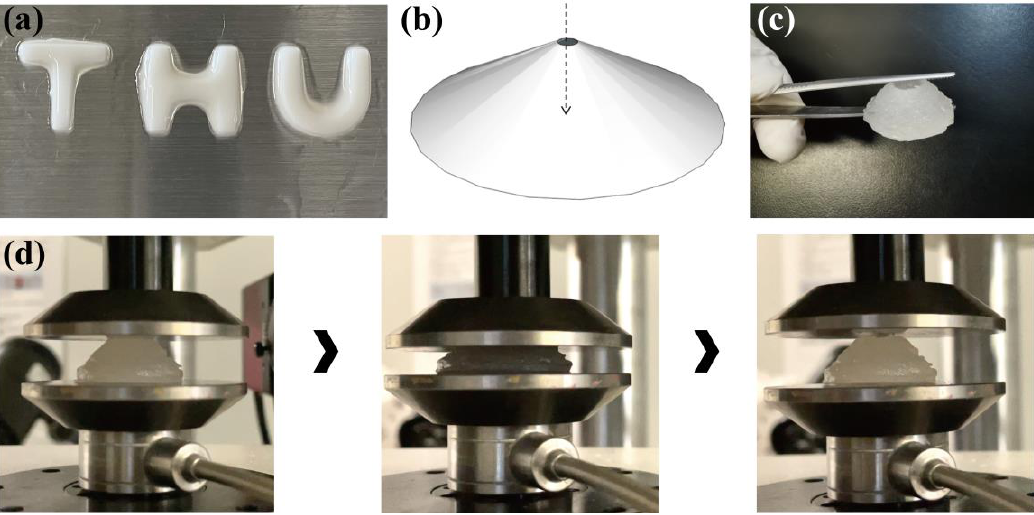
Figure 5. ( a ) “THU” model printed by DLP. ( b ) CAD file of a cone with hollow structure. ( c ) A cone with hollow structure printed by DLP. ( d ) Compression and rebound of the printed structure.